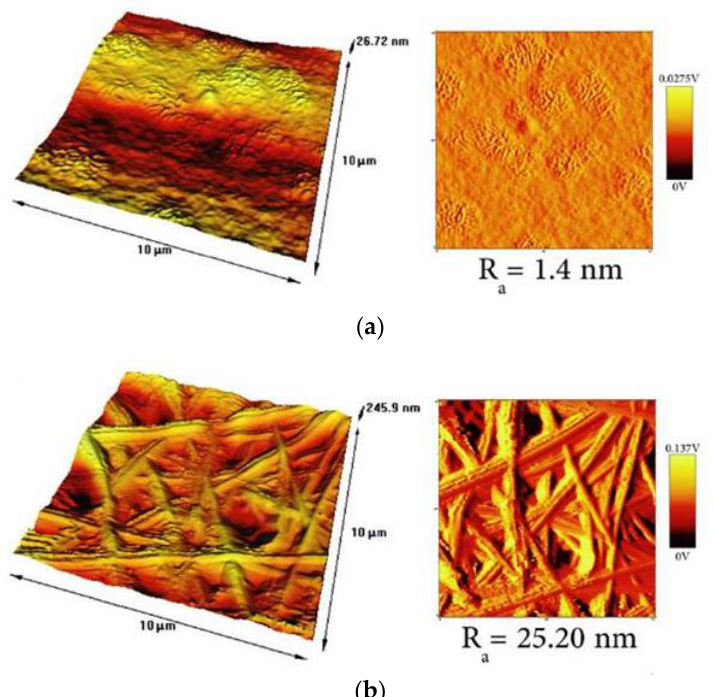
Figure 8. Comparison of the surface topography between a film ( a ) and nanofibers ( b ), both made of chitosan. The nanofibers show a rough structure favorable to the attachment of bacteria. Adapted from [147], originally published under a CC-BY 3.0 license.